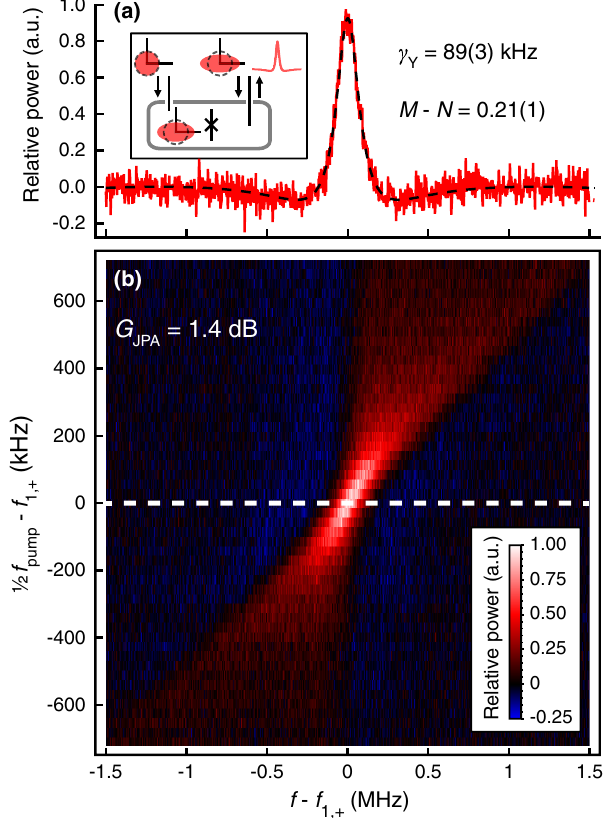
FIG. 2. (a) Reflected power as a function of frequency for 1 . 4 dB). The excitation with only squeezed vacuum ( G JPA ¼ spectrum is normalized by a measurement in ordinary vacuum to account for the JTWPA ’ s gain ripple. Zero relative power corresponds to the background level of the broadband squeezed power. The red ellipses are phase-space representations of the squeezed states inside and outside the cavity as inferred from the fit to Eq. (2). (b) Reflected power measured over a constant frequency span as the frequency of the JPA pump is varied. The peak in the spectrum diminishes and broadens as the JPA pump is detuned from the polariton